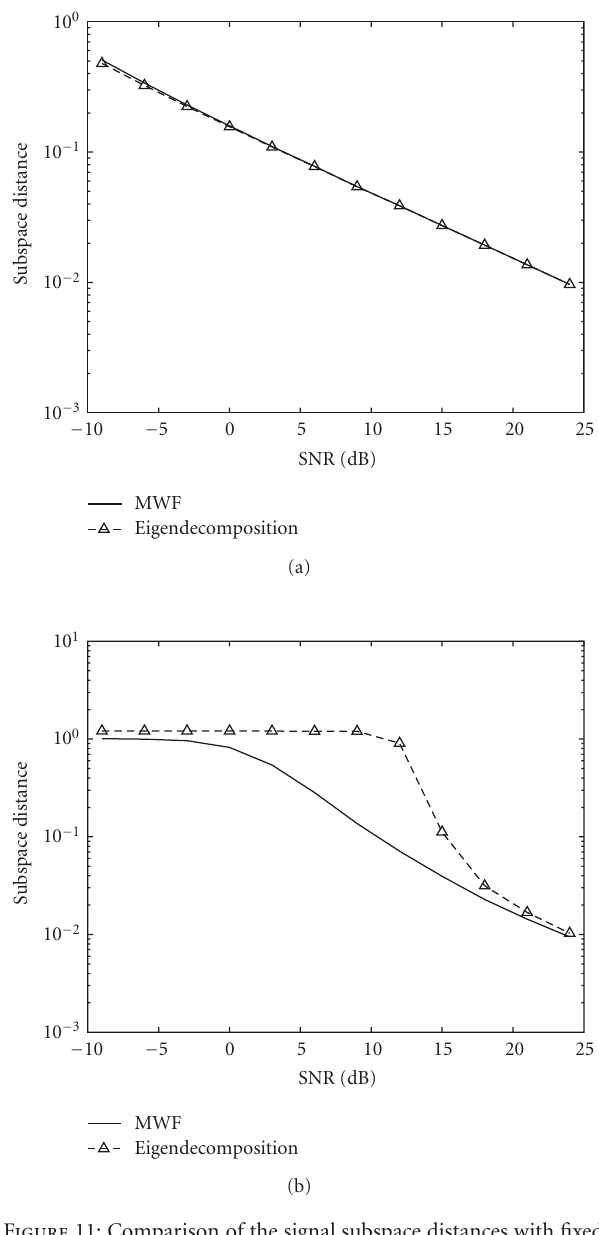
Figure 11: Comparison of the signal subspace distances with fixed M = 12, N = 100, and K = 4. (a) White noise. (b) Colored